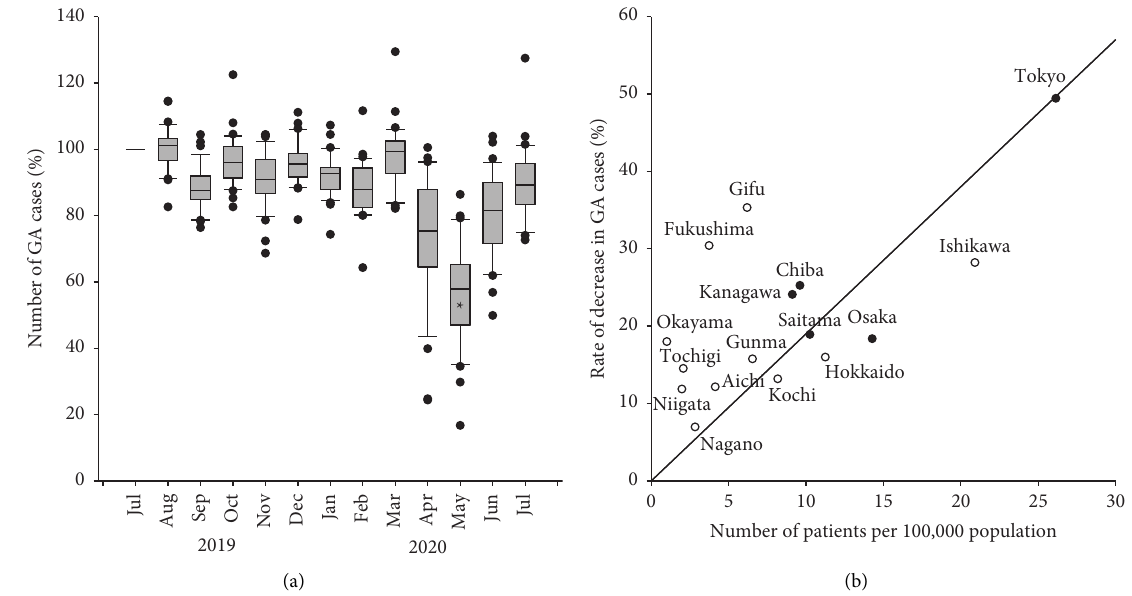
Figure 1: (a) Changes in the number of general anesthesia (GA) cases performed at the 34 facilities from July 2019 to July 2020. The ends of the box define the 25th and 75th percentiles, with the horizontal line in the middle showing the mean and the error bars defining the 10th and 90th percentiles. The dots indicate outliers. ∗ , Kruskal–Wallis with the post hoc Tukey test, P < 0 . 001. (b) Relationship between the spread of COVID-19 and the rate of decrease in the number of GA cases in each prefecture. The regression line shows the correlation between them ( R � 0.66). The prefectures where the state of emergency was issued early and the prefectures where it was issued late are indicated by closed and open circles,